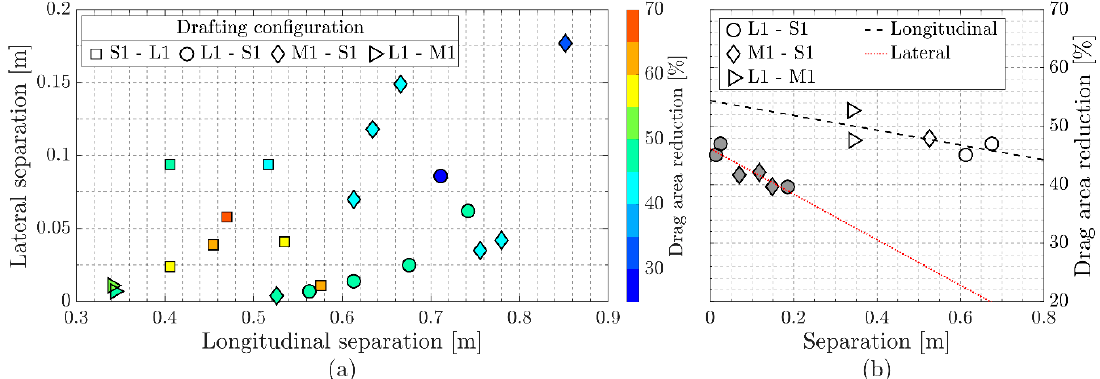
Figure 3. ( a ) Reduction in drag area for the drafting cyclist at different positions behind the lead cyclist. ( b ) Effect of longitudinal and lateral separations on the drag reduction of the trailing cyclist. The filled symbols correspond to varying lateral separation with a longitudinal distance of 0.65 m ± 0.04 m. The empty symbols correspond varying longitudinal separation with a lateral separation of 0 m ± 0.02 m.